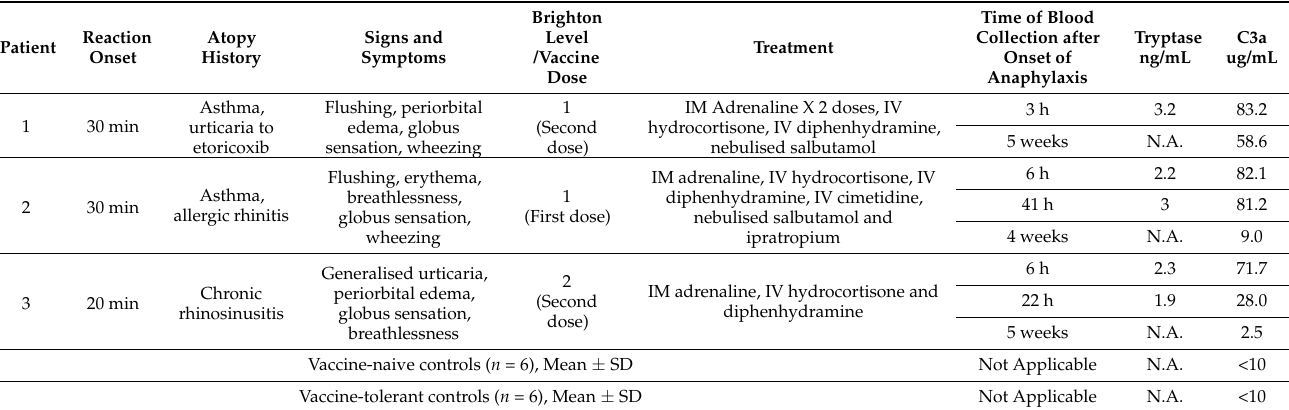
Table 1. Clinical details and laboratory findings of patients 1–3 and